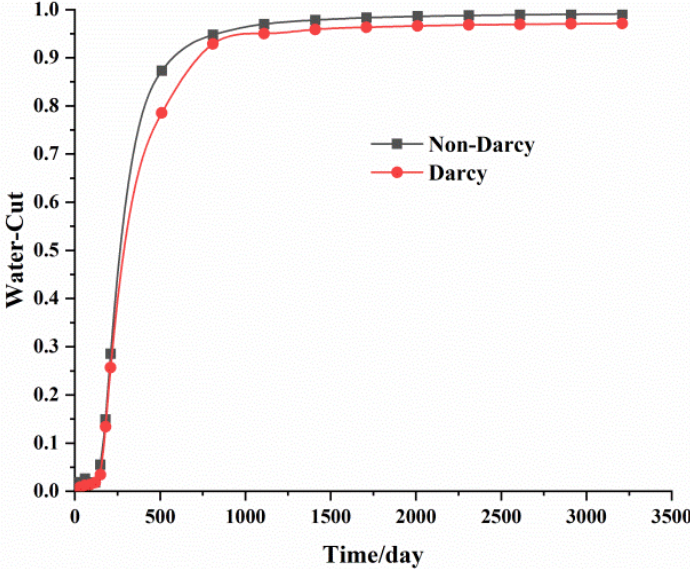
Figure 12. Comparison of water cut curves of P2 well under Darcy and non-Darcy flow mode.